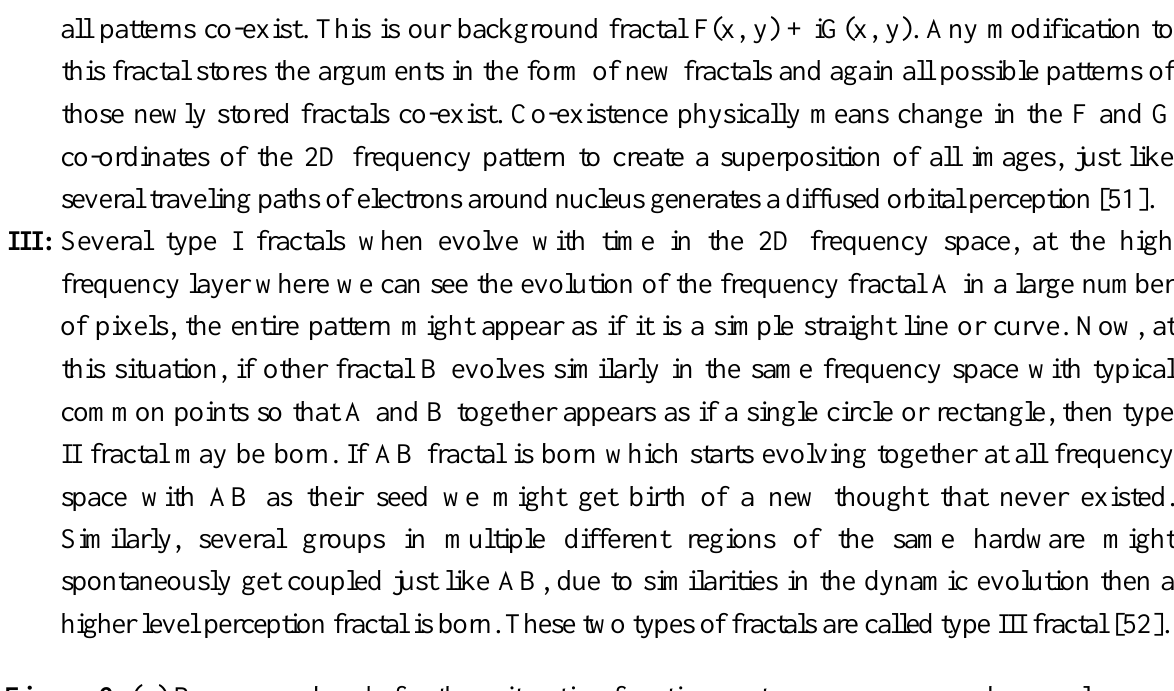
Figure 9. ( a ) Resonance bands for three iterative function systems, common peaks couple and form an argument, set of resonance peaks denoted as yellow balls; ( b ) Self-assembly of arguments form a cluster, common values form ―loop‖, ―expansion‖ ―fractal‖, etc. local networks; ( c ) Square 2D images make complex 3D net; ( d ) How resonance band change shape, when memory is